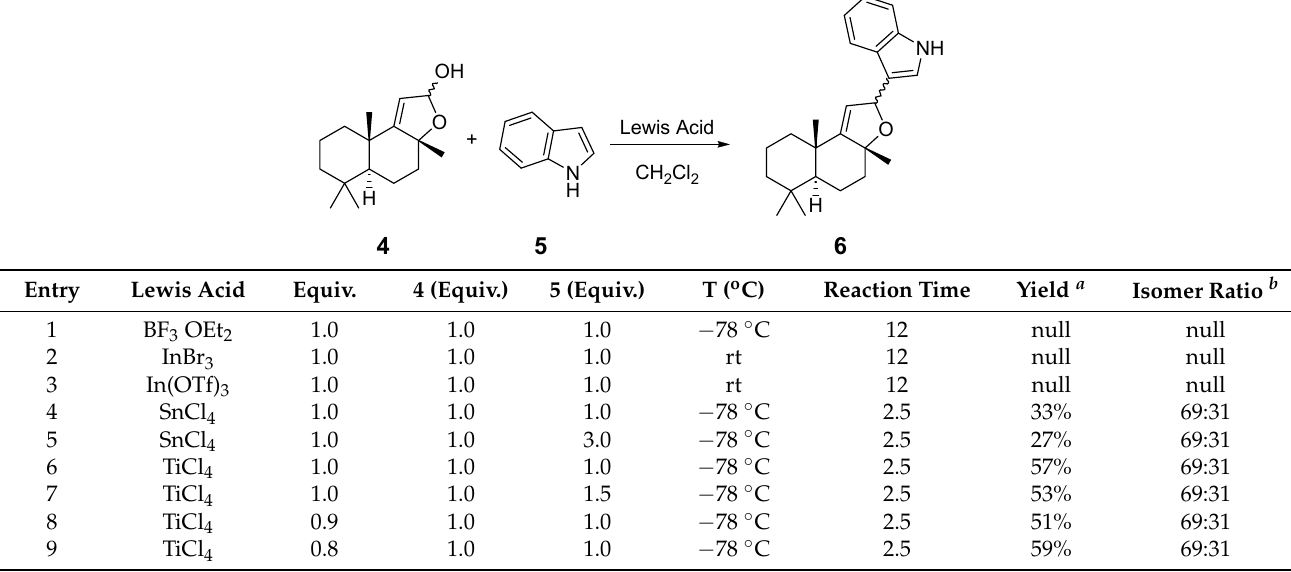
Lewis Acid CH 2 Cl